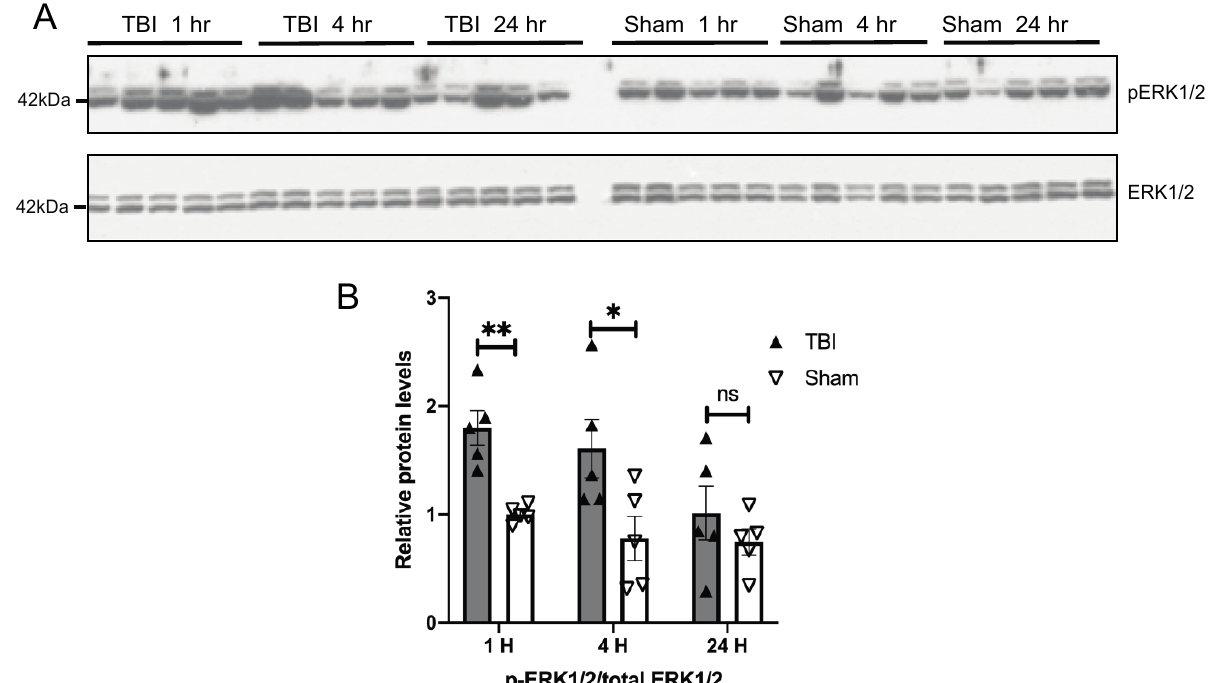
Figure 4. BOP caused the activation of extracellular signal-regulated kinase (ERK) in the mouse brain. Representative Western blots ( A ) and quantification analysis ( B ) revealed the activation of ERK after blast ( n = 5/group). (Data are means ± SEM, * p < 0.05, ** p < 0.01; ns, non-significant).